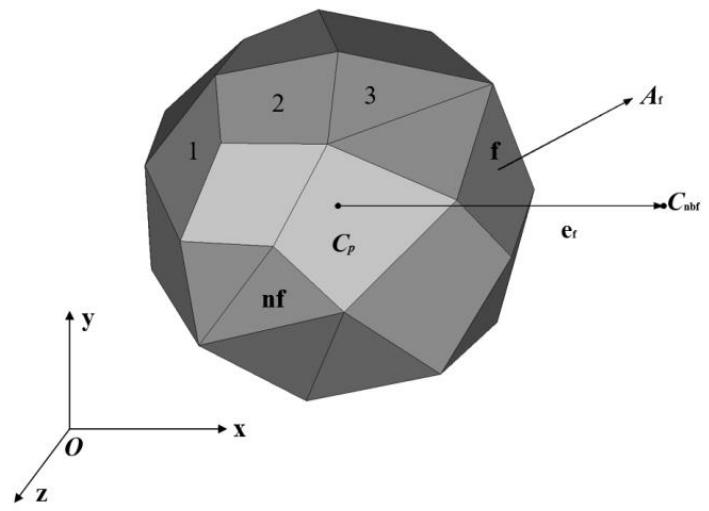
Figure A1. Control volume of cell-centered finite volume method.